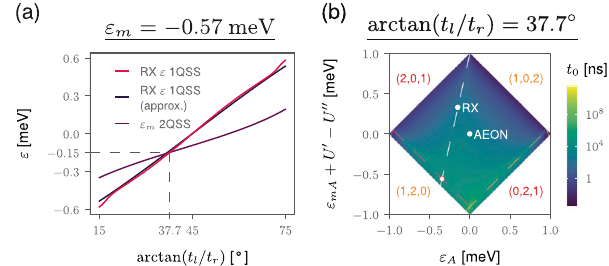
Fig. 5 RX single-qubit sweet spot (1QSS) and two-qubit sweet spot (2QSS) dependence on tunneling ratio. a The red curve shows the exact dependence of RX ε 1QSS on arctan ð t l = t r Þ . The blue line, from ref. 36 , shows the approximate dependence, ε ≈ − (8 Δ /5) y , where Δ ¼ U (cid:3) 2 U 0 þ U 00 (cid:3) ε m and small tunneling asymmetry y ¼ sin ð π = 4 (cid:3) arctan ð t l = t r ÞÞ . The purple curve shows the ε m 2QSS position as a function of arctan ð t l = t r Þ . At the intersection where both 1QSS and 2QSS share the same tunneling ratio, ε = − 0.15 meV, arctan ð t l = t r Þ ¼ 37 : 7 (cid:7) , for parameters used in this study. b The gate times at the tunneling ratio arctan ð t l = t r Þ ¼ 37 : 7 (cid:7) . At the intersection of ε m 2QSS (white dashed line) and RX 1QSS, non-local gate time is t 0 = 198